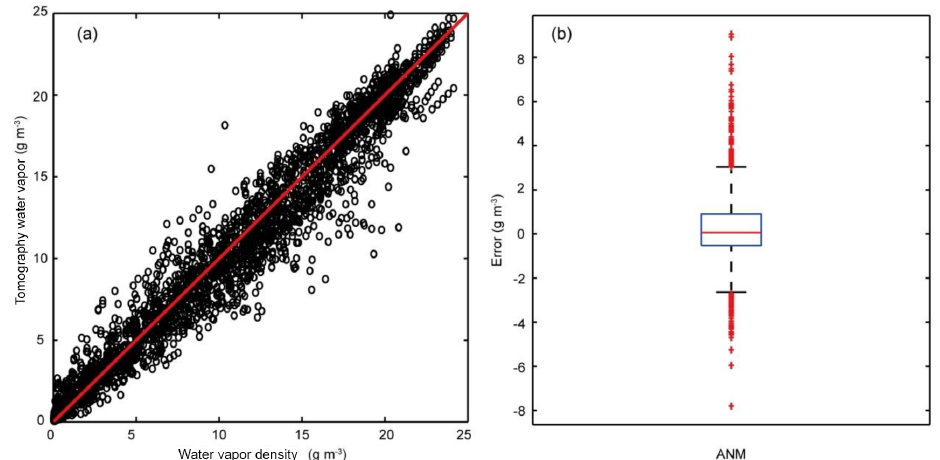
Figure 10. Graphic presentation for the distribution of the tomographic results at the two epochs on every day during the month: (a) scatter plot of water vapor density and (b) box plot for outlier detection of the tomographic errors.